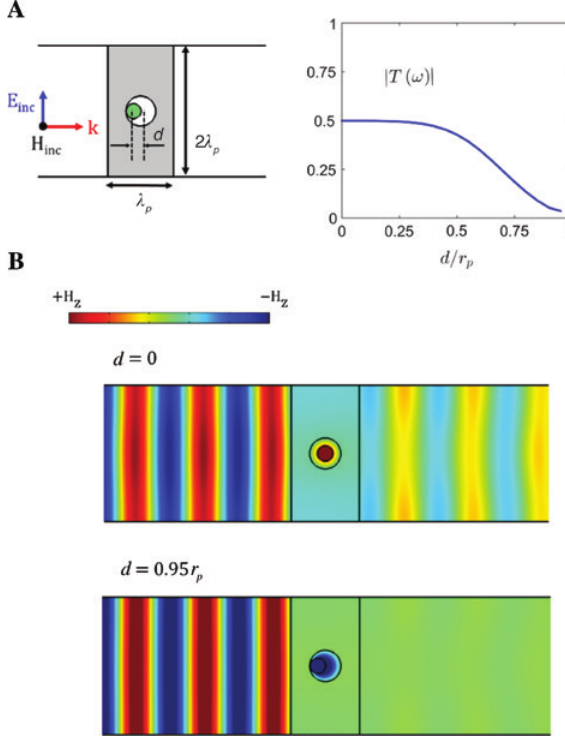
Figure 6: Tuning ENZ metasurfaces photonically doped with mechanical actuators. × λ (A) Sketch of the geometry: ENZ rectangular unit cell of size 2 λ p p = 0.114 λ containing a dielectric rod of radius r and relative permit- p p = 10, which is located within a vacuum rod of radius 2 r tivity ε . The p p transmission of the metasurface is modulated by shifting the posi- tion of the dielectric rod a distance d from the center of the vacuum rod. Magnitude of the transmission coefficient as a function of the position of the dielectric rod. (B) Snapshot of the magnetic field distribution at the position for the positions (B-top) d = 0 (maximal transmission) and (B-bottom) d = 0.95 r (minimal transmission). p The numerical simulations illustrate the possibility of modulating the transmission coefficient from 0.5 to nearly 0 with the use of a mechanical